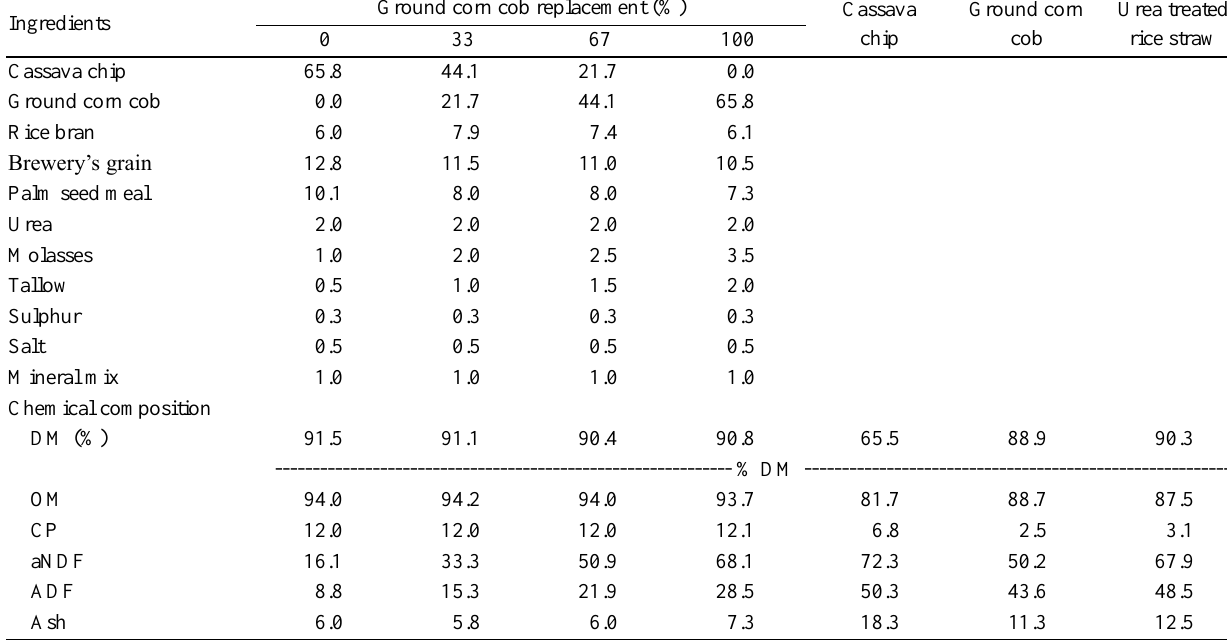
Table 1. Ingredients and chemical composition of concentrate mixture used in the experiment